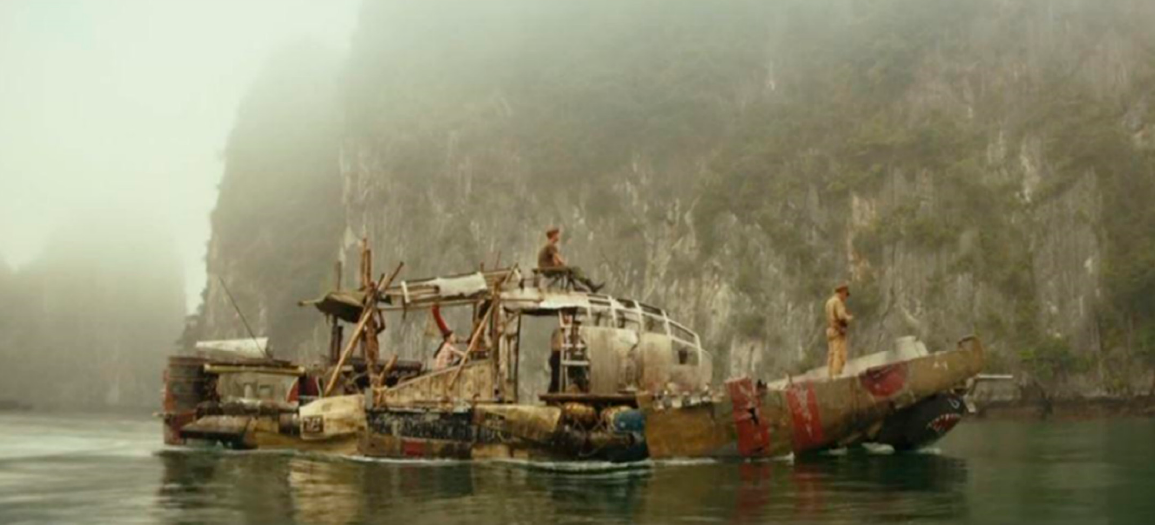
Figure 3. On leaving the island, the fog covers it (2017). https://www.reddit.com/r/MovieDetails/comments/8irzvk/in_kong_skull_island_theres_a_boat_named_gray_fox/ (accessed on1 January 2021). Religions 2021 , 12 , x FOR PEER REVIEW